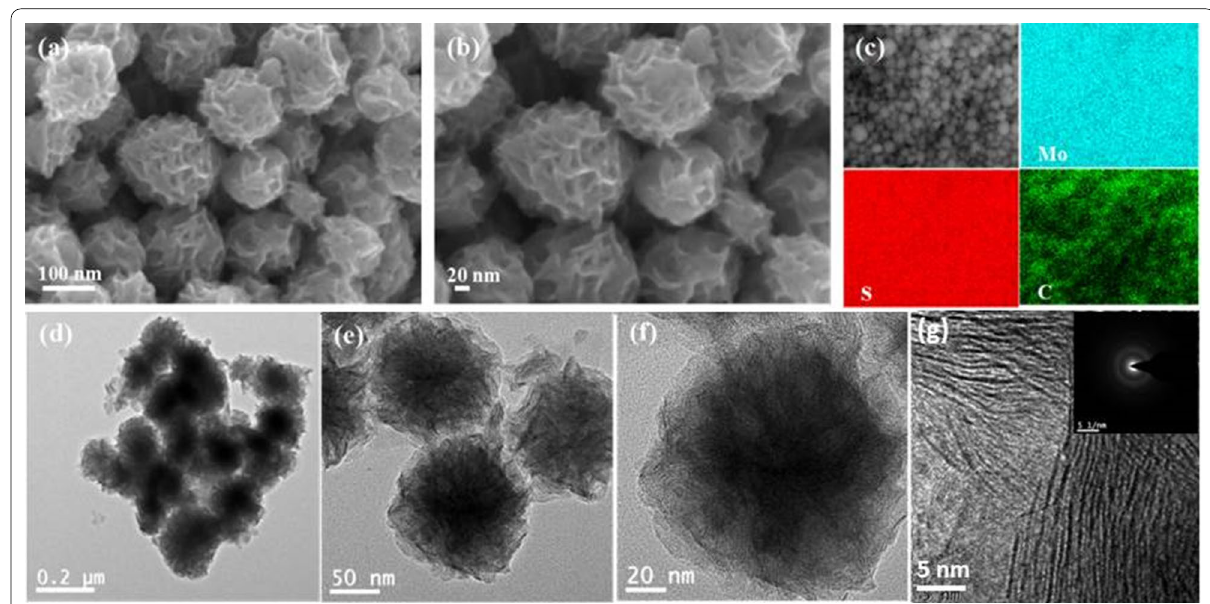
Fig. 4 a , b FESEM images; c FESEM district elemental mapping images; d – f TEM images; g HRTEM images and the inset of corresponding SAED pattern of MoS 2 /C